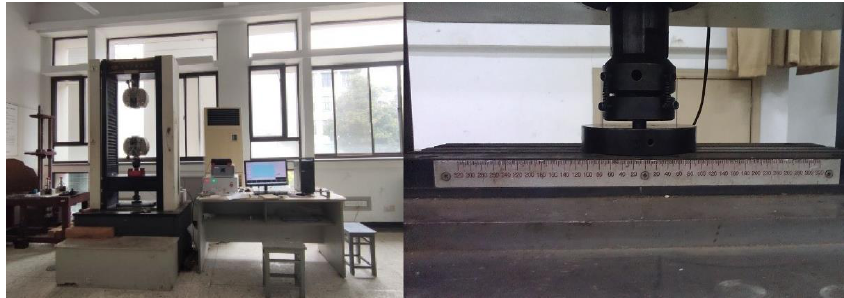
Figure 2. The test layout of the quasi-static compression test.